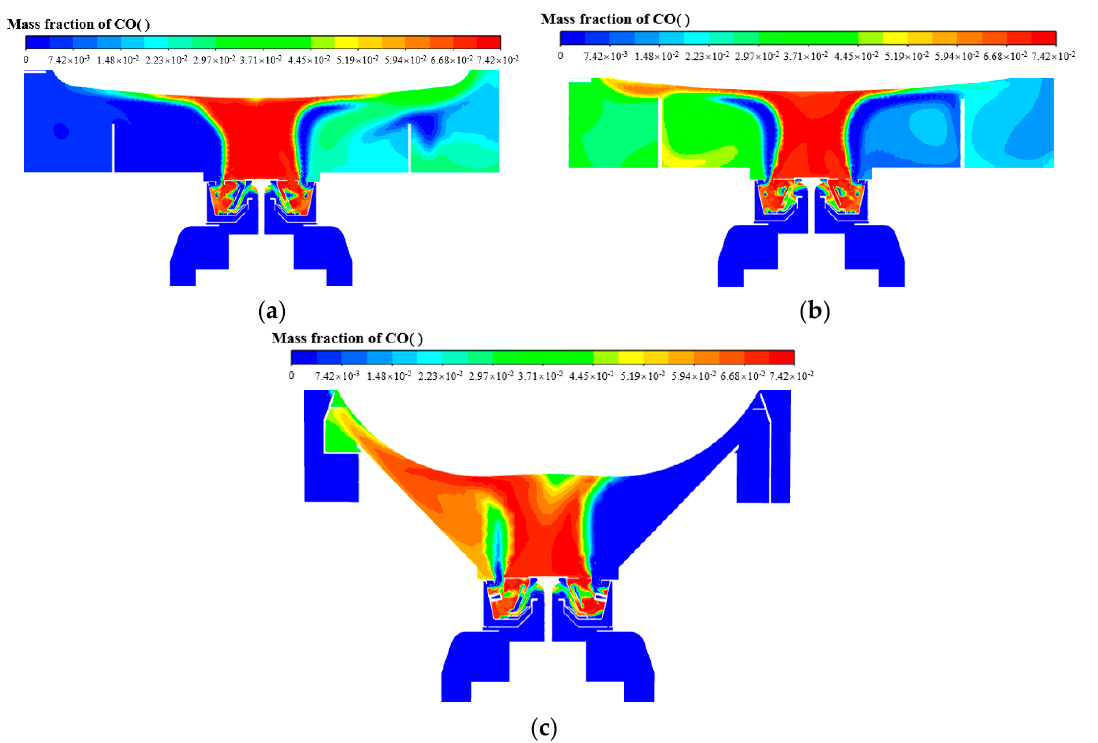
Figure 13. CO mass fraction contours of the central section of the three stoves at 40 kW: ( a ) staple